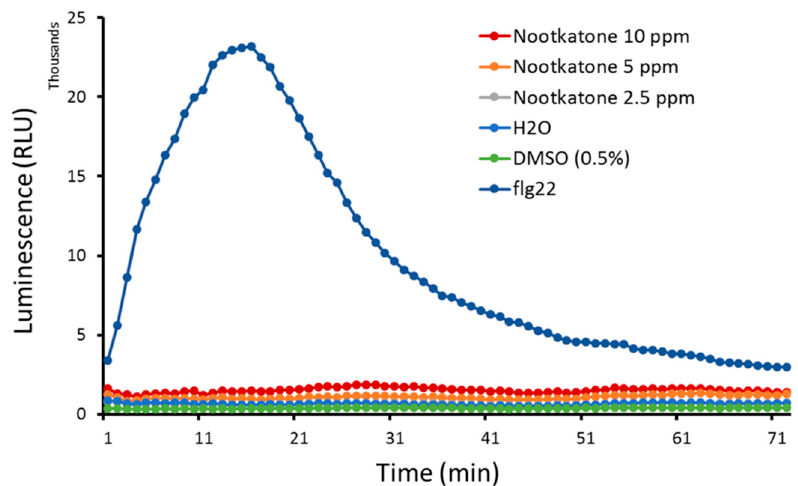
Figure 5. Arabidopsis leaf disc reactive oxygen species (ROS) production in response to nootkatone exposure. A. thaliana leaves were exposed to different concentrations of nootkatone, the bacterial elicitor peptide flg22 as a positive control or water and 0.5% DMSO as negative controls. The ROS presence was measured in relative light units (RLU) using a luminol-based assay during a 75-min-long incubation. Data show the mean value of 3 biological replicates, n = 12.